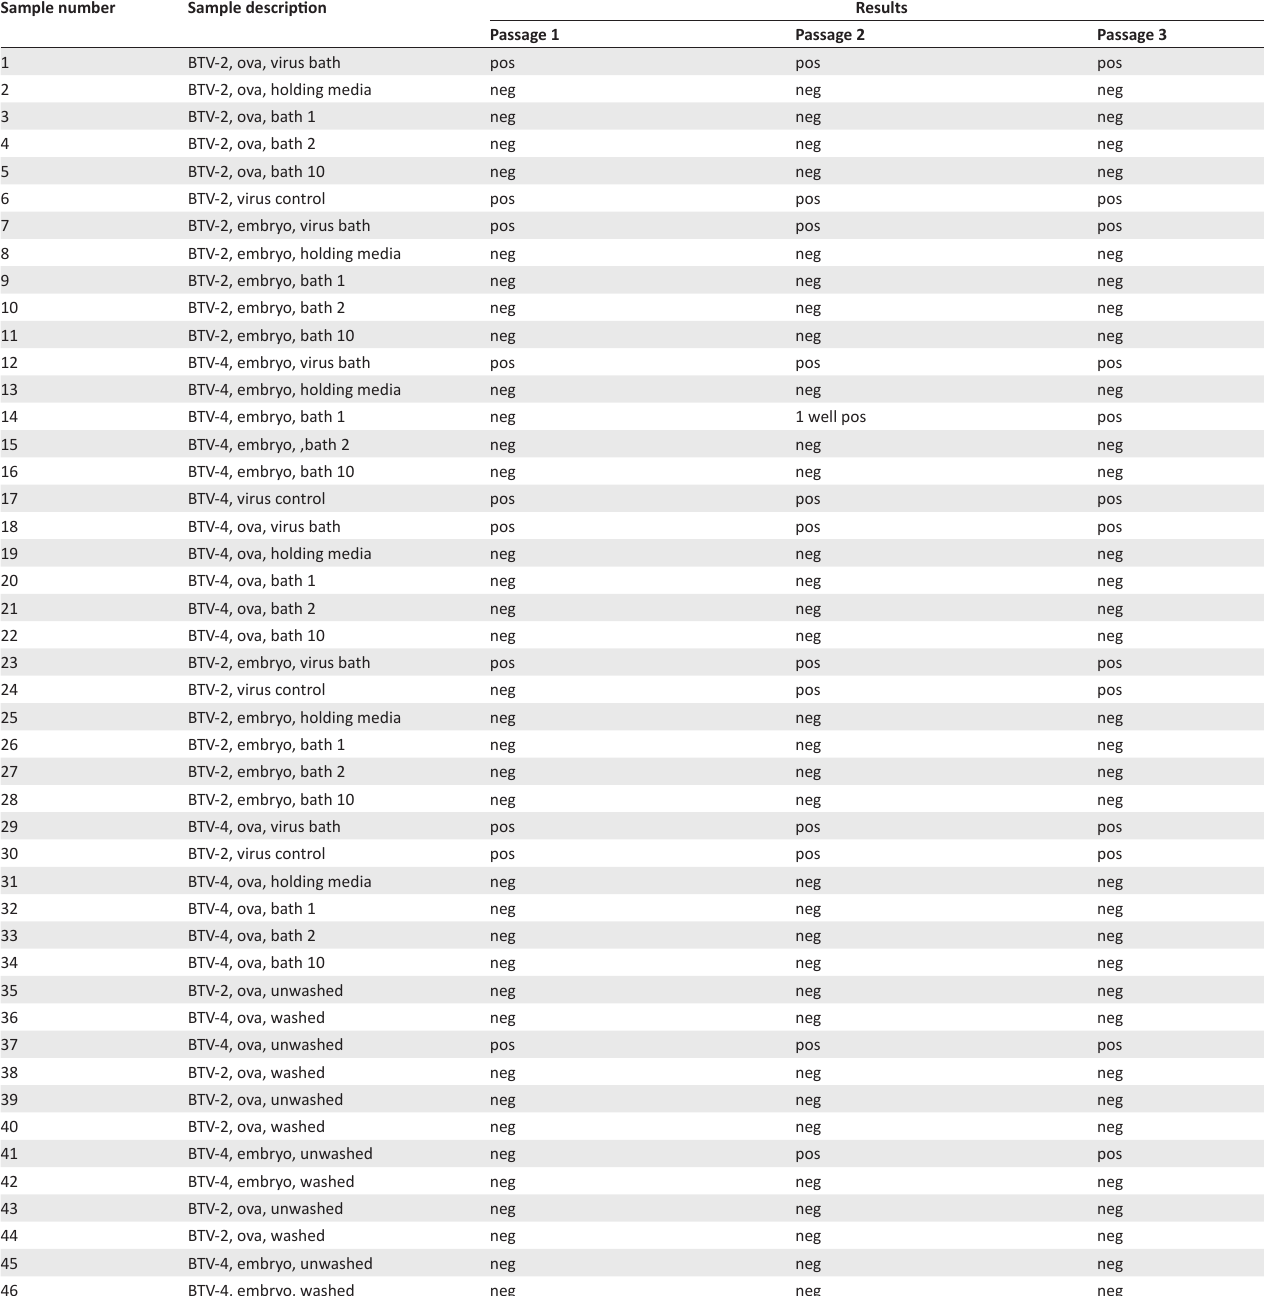
TABLE 3: Results from embryos exposed to BTV in vitro , washed and passaged three times on BHK-21 cells (Experiment 1). Sample